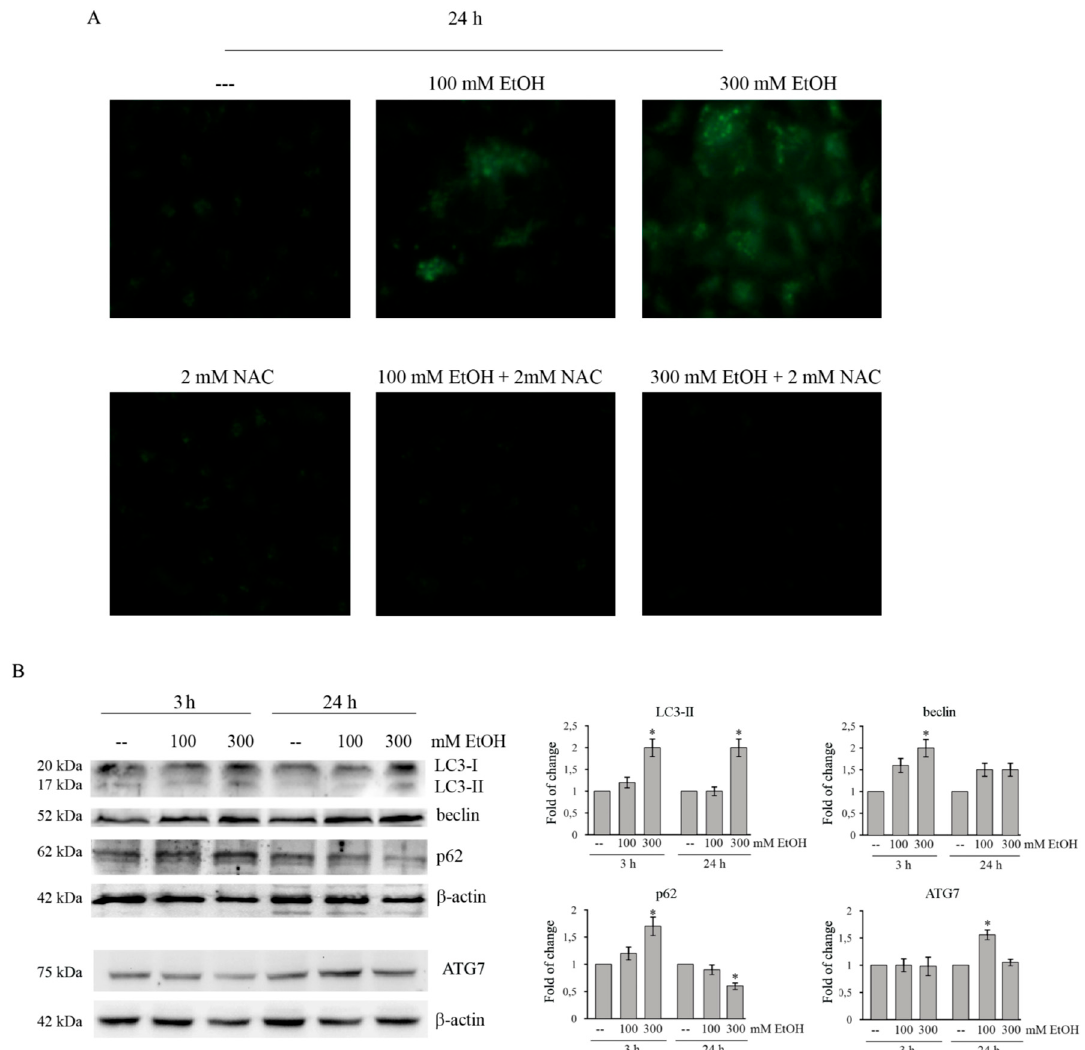
Figure 3. Ethanol induces autophagy in HCT116 cells. ( A ) HCT116 cells (7 × 10 3 ) were treated with 100 or 300 mMEtOH for 24 h in the presence or absence of 2 mM NAC. Autophagic vacuoles production was assayed by MDC staining under a Leica DC300F microscope (400 × original magnification) using a DAPI filter. Results are representative of three independent experiments. ( B ) Western blotting analysis of LC3, beclin, ATG7, and p62 in HCT116 cells treated for the indicated times with 100 or 300 mM EtOH. Quantitative estimations of the protein levels were determined by densitometry measurements of Western blotting from three independent experiments after normalization with β -actin. (*) p < 0.05 compared to the untreated